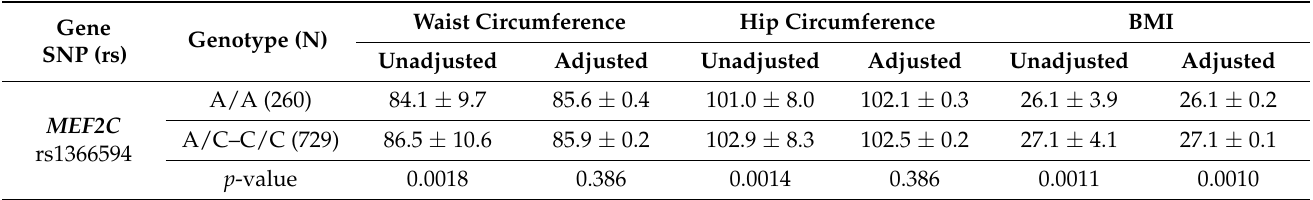
Table 4. Association of MEF2C SNP, according to the inheritance model, with BMI, and waist (WC) and hip (HC) circumfer- ence. WC and HC were adjusted for BMI and age, whereas BMI was adjusted for age. Unadjusted values are means ± SD. Adjusted values are estimated means ± SE.